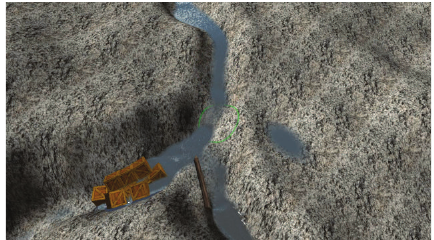
Figure 12: A dam built out of crates changes the river flow (our method).